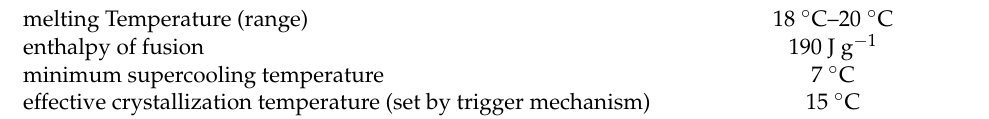
Table 1. Essential input of estimated material data of programmable PCM for hygrothermal simulation. melting Temperature (range)